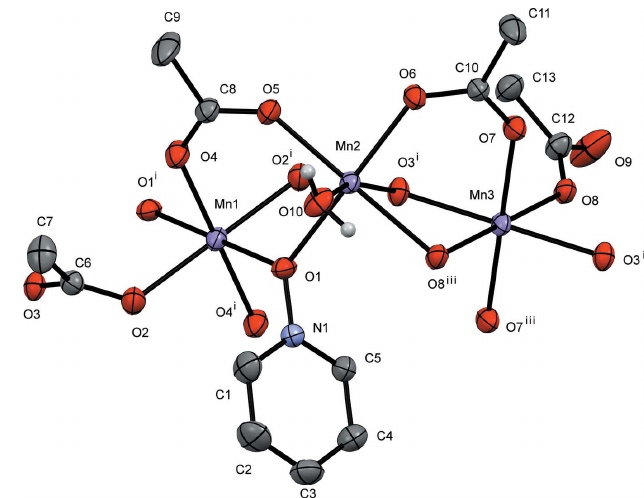
Figure 1 A view of compound I , showing the atom labeling. Displacement ellipsoids are drawn at the 50% probability level, H atoms not involved in hydrogen bonding have been omitted for clarity. [Symmetry codes: (i)